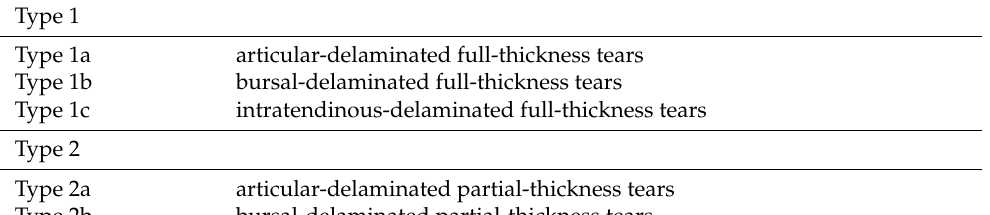
Table 2. Delaminated tears of full- and partial-thickness tears by Choo et al. [11].